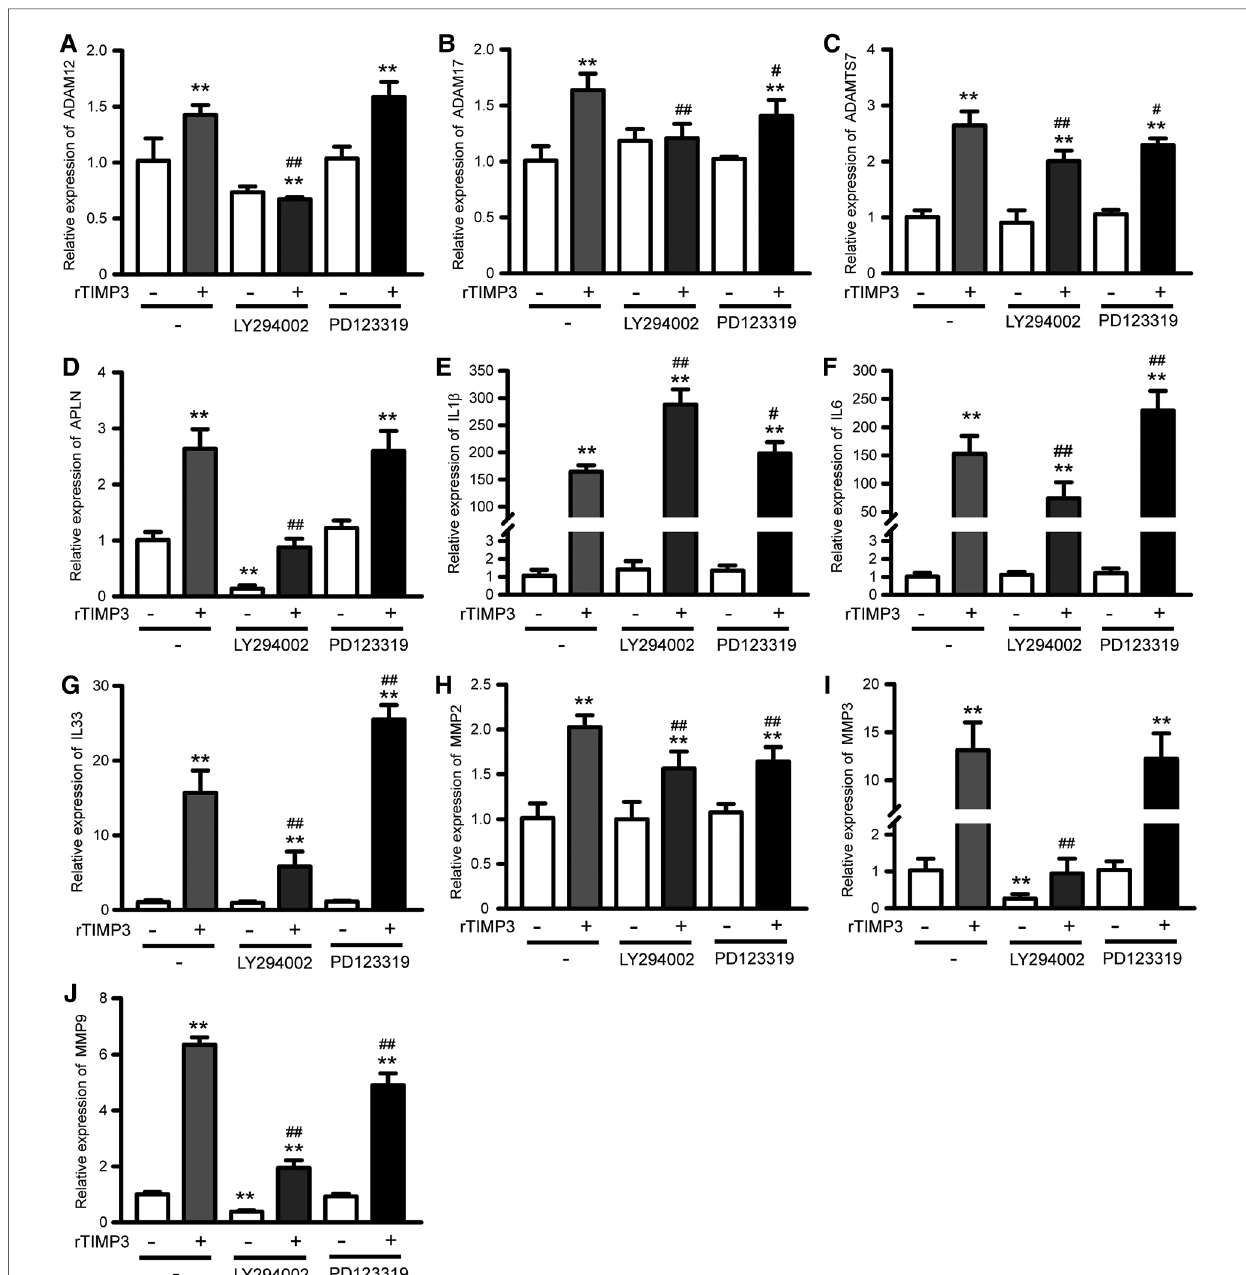
FIGURE 4 Pi3k and AGTR2 participated in rTIMP3-induced gene expression. Neonatal rat ventricular myocytes were treated with rTIMP3 (100 ng/ml) for 48 h with or without pre-incubation of speci fi c inhibitors for phosphoinositide-3-kinase (PI3K, LY294002, 10 μ M) or Type-2 angiotensin II receptor (AGTR2, PD123319, 1 μ M) for 30 min. Total RNAs were collected and mRNA levels of ADAM12, ADAM17, ADAMTS7, APLN, IL1 β , IL6, IL33, MMP2, MMP3, and MMP9 were detected by using real-time PCR ( n =3). ** p <0.01 vs. control, # p <0.05, ## p <0.01, vs.